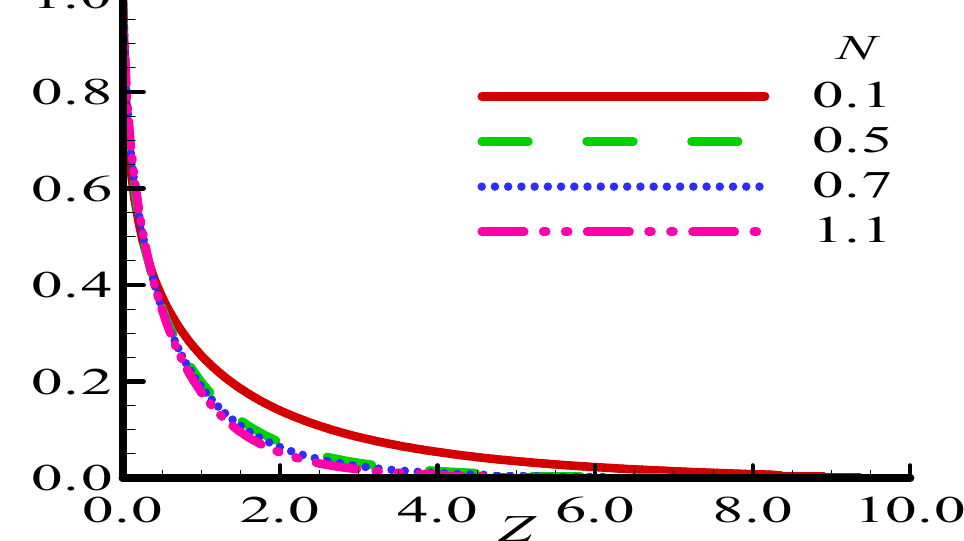
Figure 13. Outcomes of radiation parameter N on temperature distribution θ when Nb = 1.5, Nt = 1.5, Pr = 7.0, and Sc =